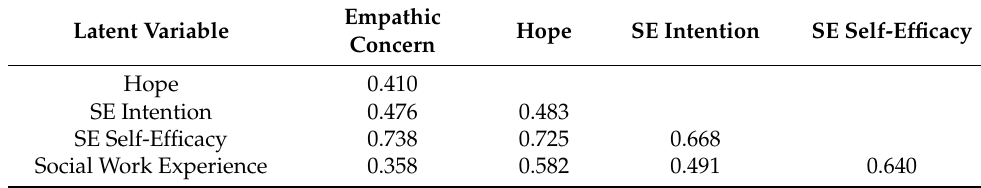
Table 5. Heterotrait–Monotrait